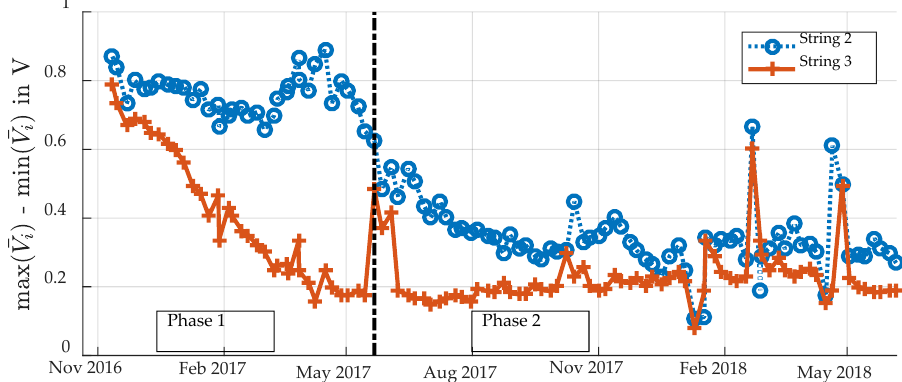
Figure 1. Deviation between the weekly maximum and minimum average mono-block voltage V i for both strings over time. The measurement period was divided into two phases as soon as string 2 reaches a delta of 0.5 V.